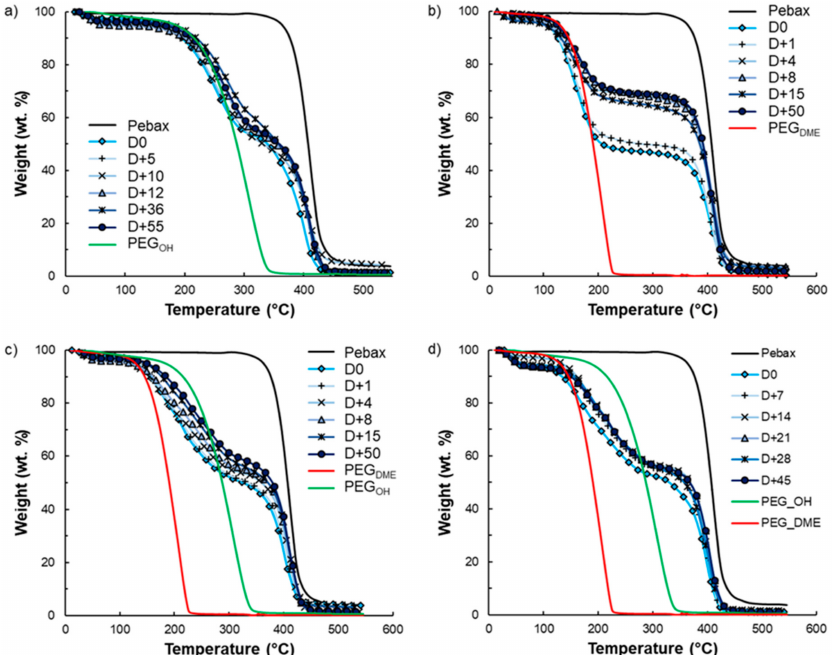
Figure 14. Film stability over time followed by TGA analysis for Pebax ® /PEG OH blends ( a ), Pebax ® /PEG DME blends ( b ), Pebax ® /PEG OH /PEG DME blends with a 50/50 PEG OH /PEG DME weight ratio ( c ), and Pebax ® /PEG OH /PEG DME blends with a 37.5/62.5 PEG OH /PEG DME weight ratio ( d ). The additive amount was 50 wt.% for all systems. “D0” represents the day when a dry film was obtained, i.e., 48 h after the film’s conception.